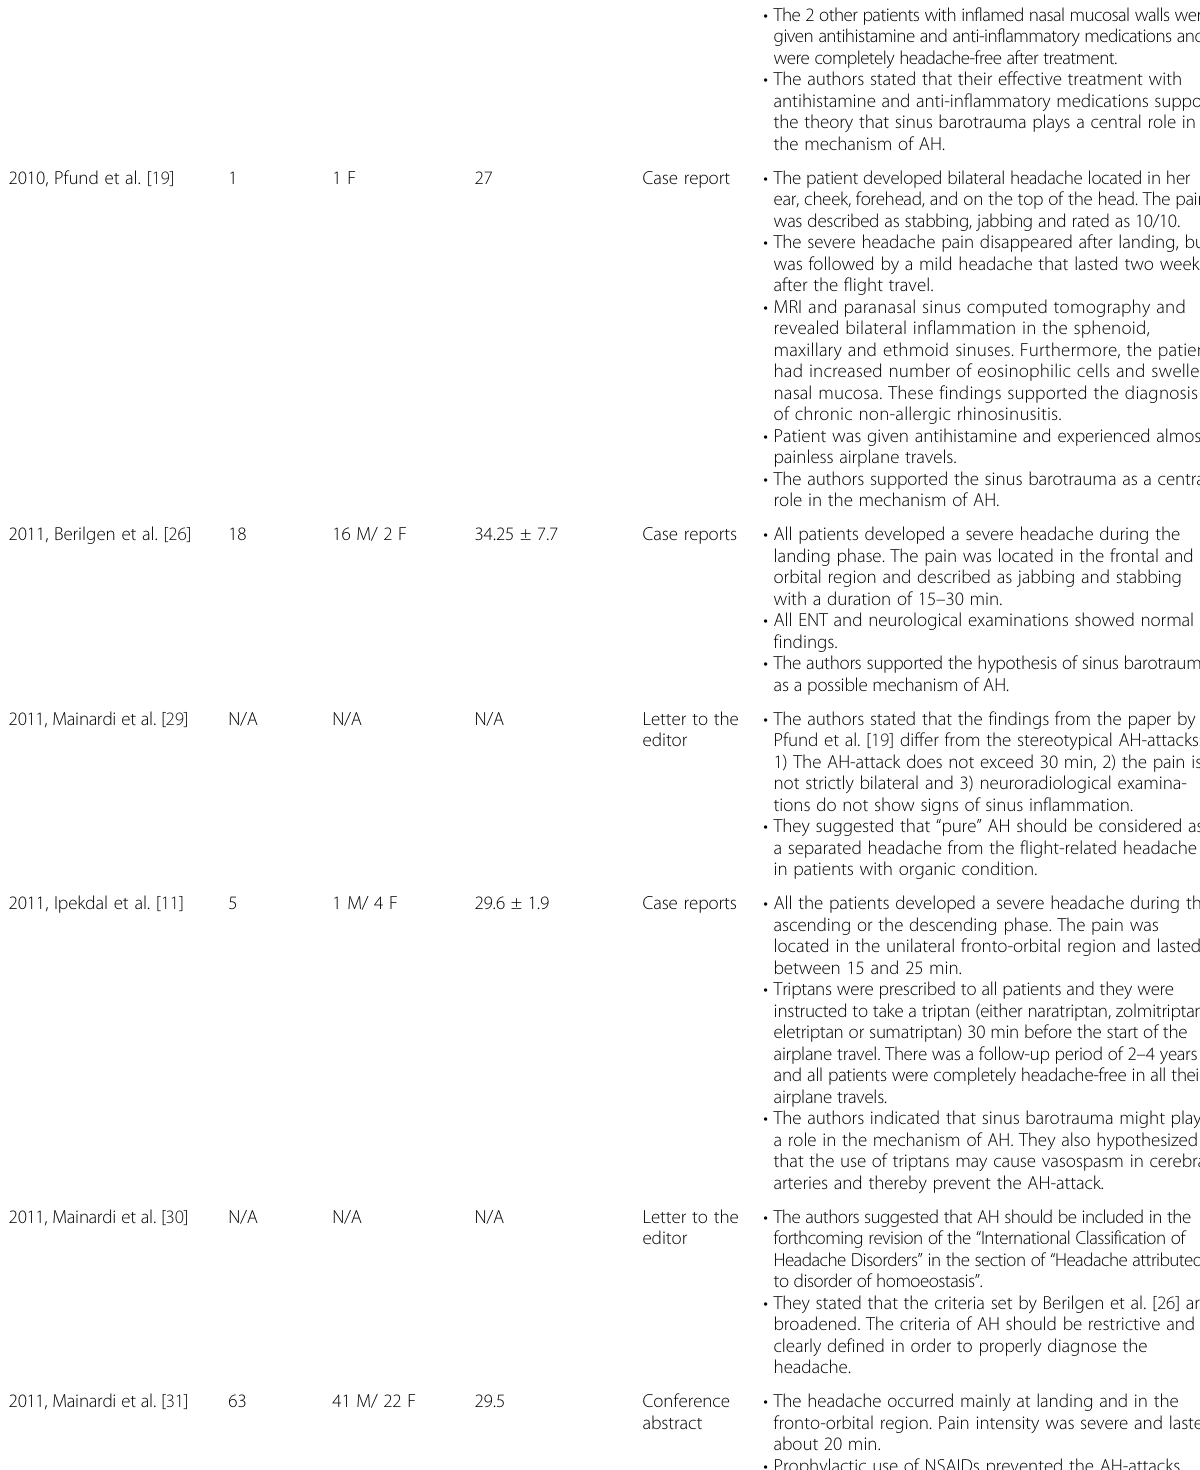
Table 1 Demographic characteristics and main outcomes of the current literature regarding headache attributed to airplane travel